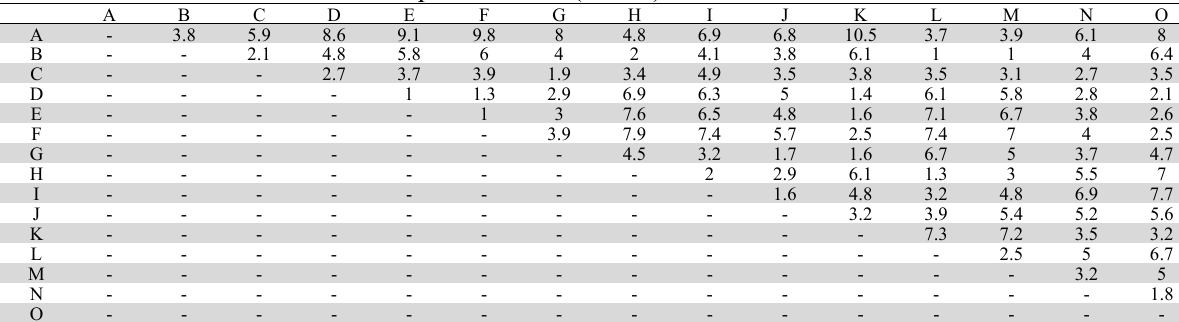
Fig. 1. Map of Tabriz city Fig. 2. Location of fifteen demand nodes The shortest distance between each pair of nodes (in